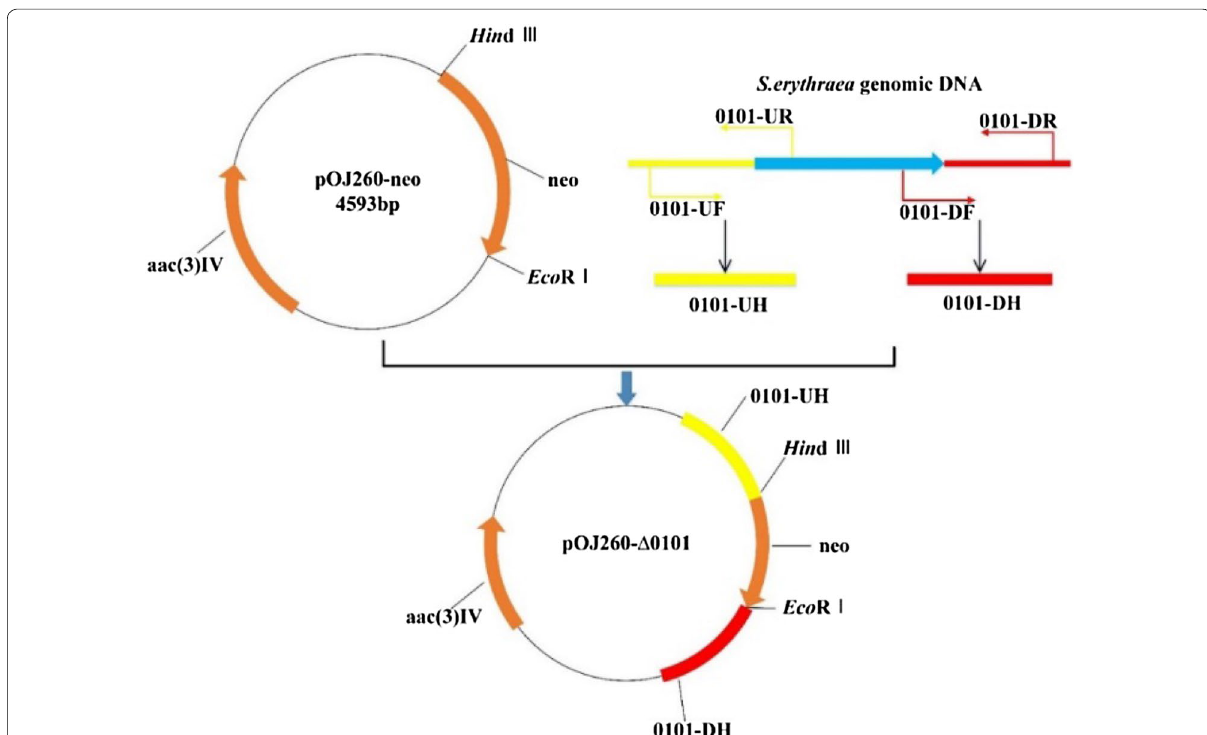
Fig. 1 Construction of recombinant plasmid pOJ260-Δ0101. The upstream and downstream of the gene SACE_0101 are inserted into HindIII and EcoRI site of the pOJ260 vector,